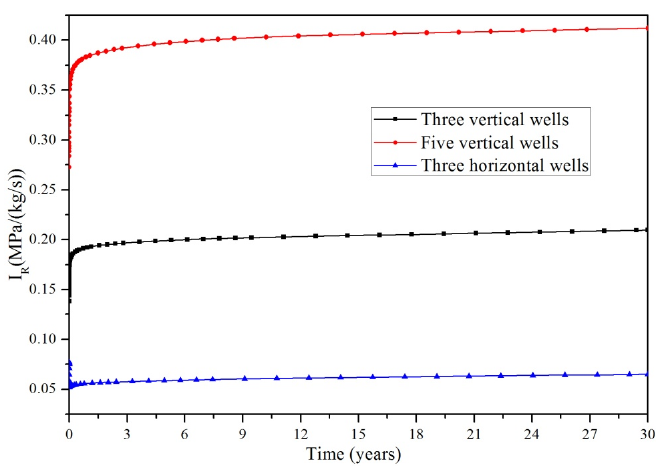
Figure 9. The change of reservoir impedance versus time under different well layouts.